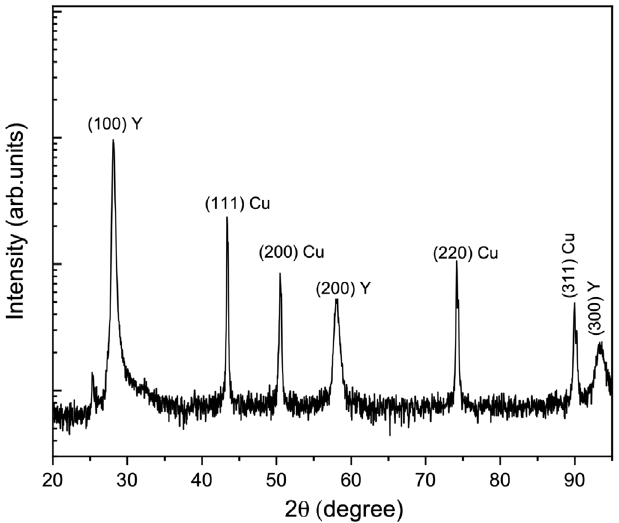
FIG. 1. XRD pattern of the Y film deposited on the Cu polycrystalline